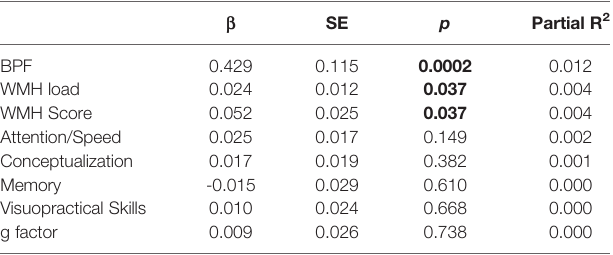
TABLE 3 | Strati fi ed analyses of the signi fi cant association of leukocyte telomere length (LTL) with magnetic resonance imaging (MRI) correlates and cognitive